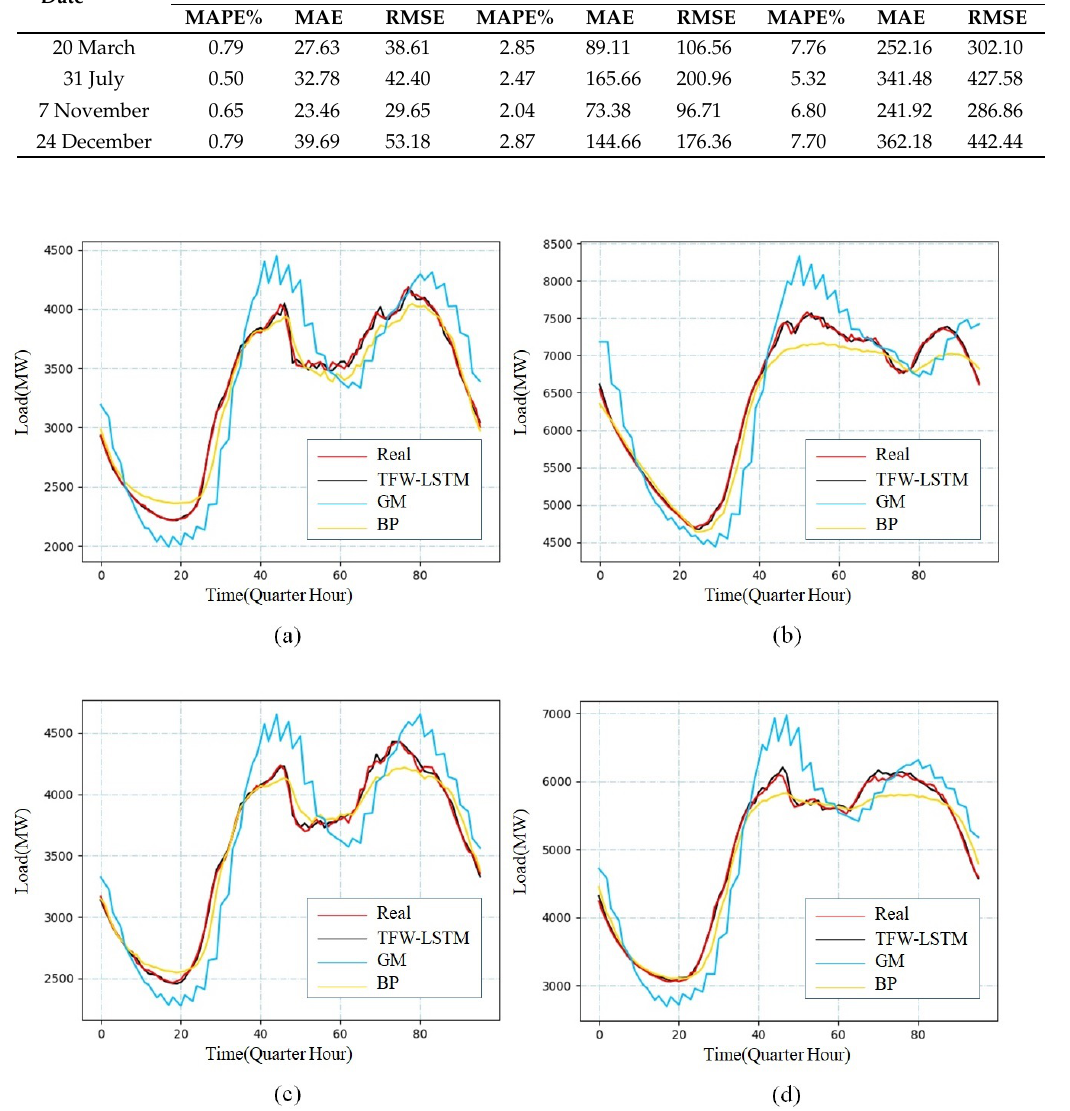
Figure 9. Prediction results for ( a ) 20 March 2019, ( b ) 31 July 2019, ( c ) 7 November 2019, and ( d ) 24 Decmber 2019. The “Real” stands for the actual value, the TFW-LSTM is our method, the “GM” is the traditional gray model, and the “BP” is the traditional back propagation neural network